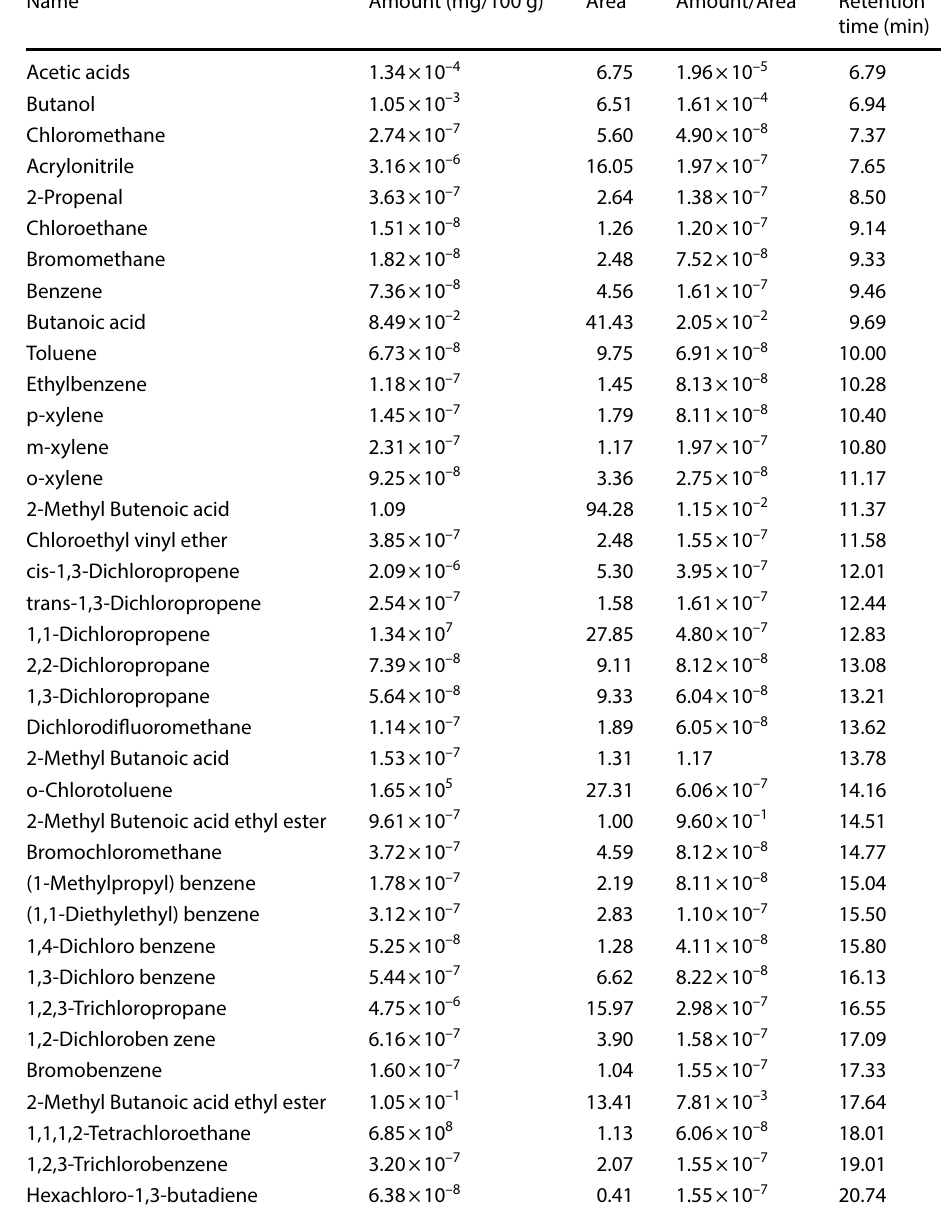
Table 8 Names and amount of the various volatile organic constituents present in dichloromethane fraction